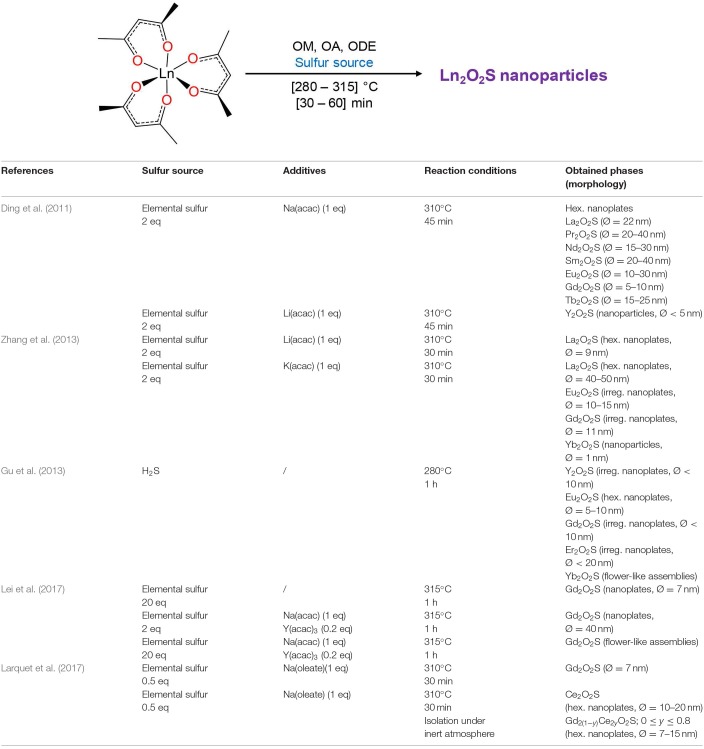
Ding's alkali-based synthesis of lanthanide oxysulfide and its derivatives. The number of equivalent (“eq” in the table) is the molar ratio between the reactant and metal. The term “hex.” stands for “hexagonal” and “irreg.” for “irregular.”